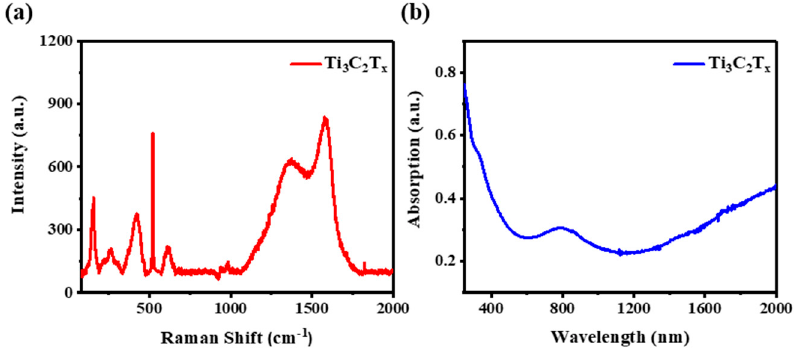
Figure 2. ( a ) the Raman spectrum of Ti 3 C 2 T x ; ( b ) UV–Vis–NIR absorption spectrum.